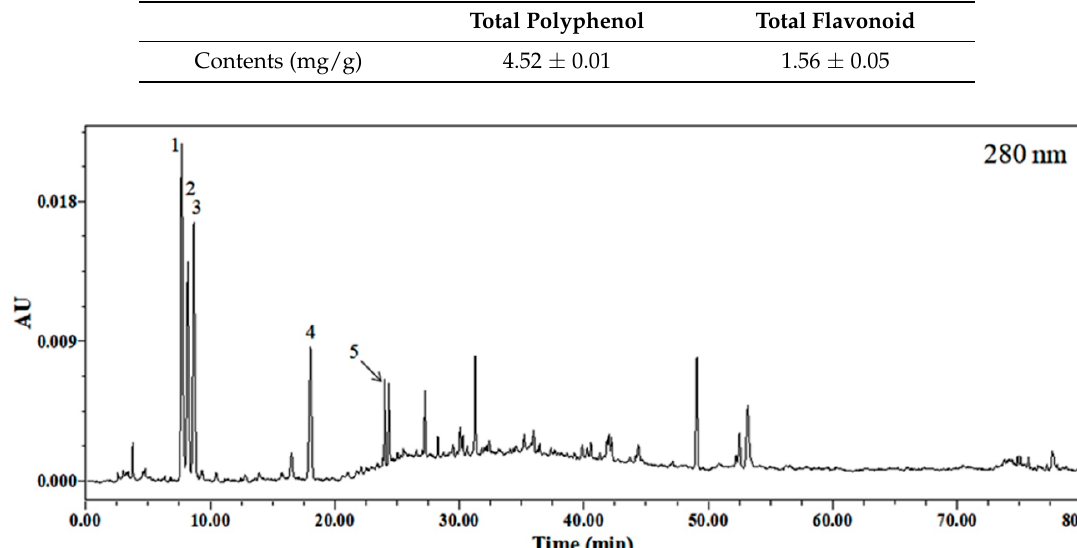
Table 2. Total polyphenol and flavonoid contents of EEP.